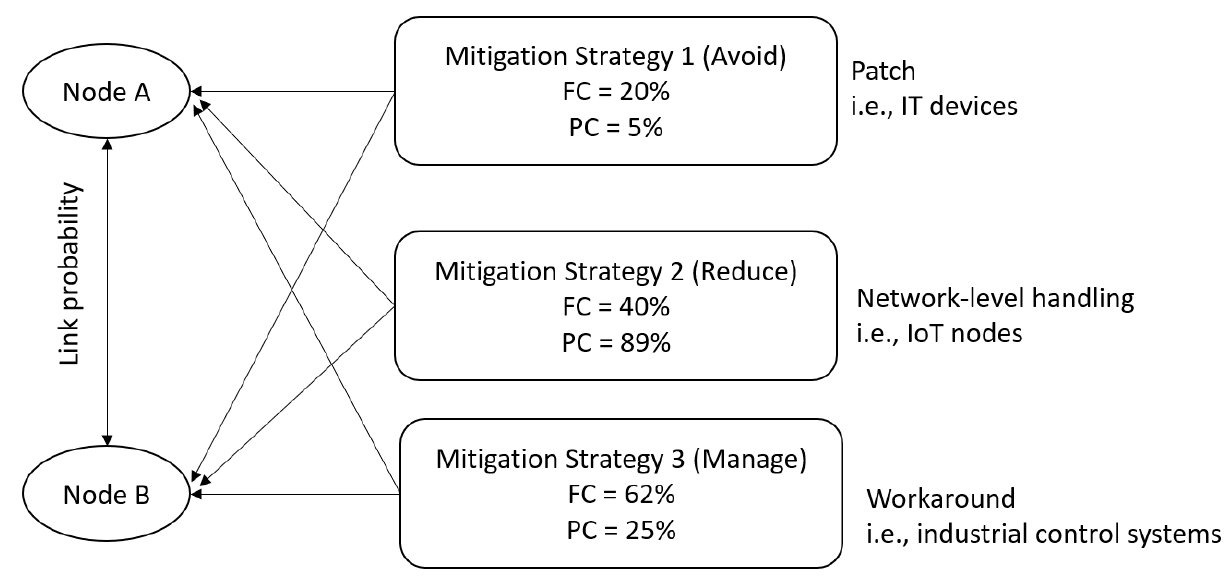
Figure 1. Mitigation categories. The FC and PC depend on the relationship between the parent and child nodes. There is either AND or OR relation between the child and its parent node. In an AND-type relationship of child nodes with the parent, the financial cost of mitigation of a vulnerability would be equal to the FC factor of the child node with the lowest value. The same would be the case for the PC factor, as per Figure 2.